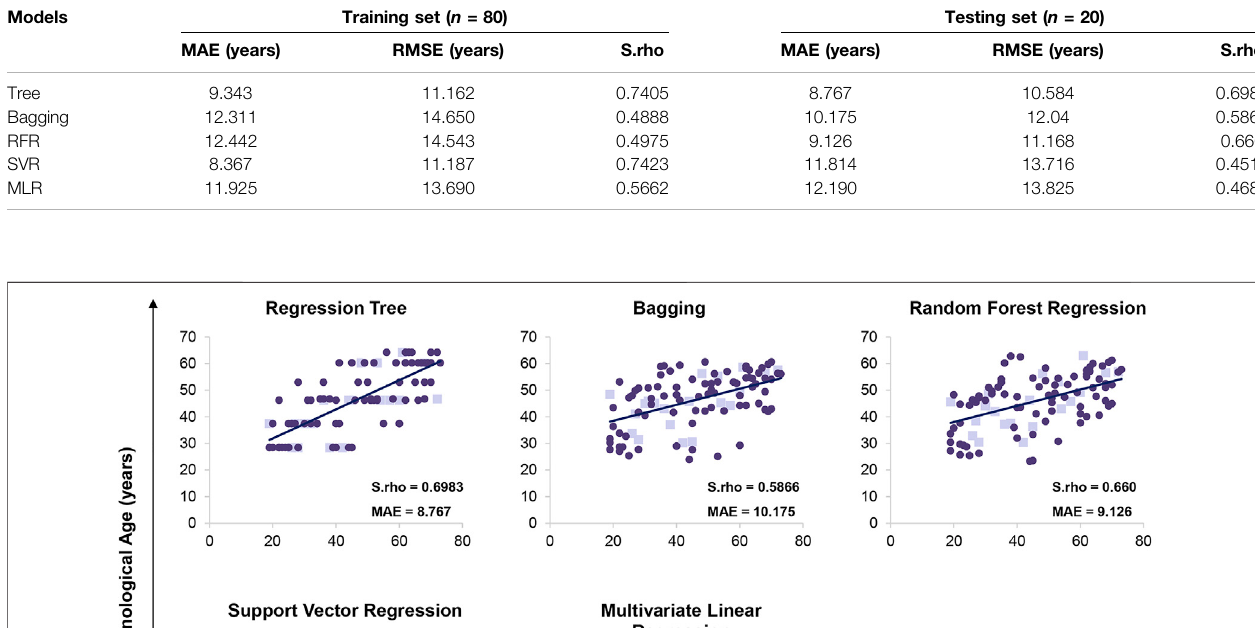
TABLE 2 | Comparison of fi ve prediction models. Models